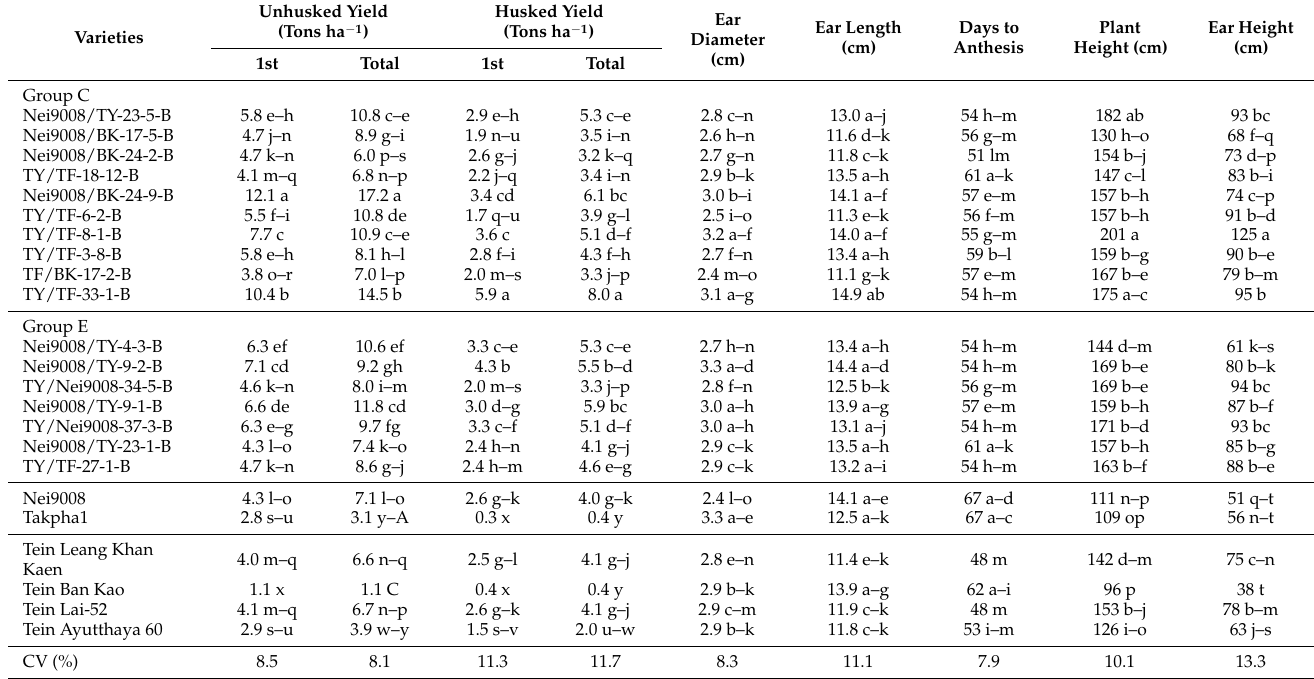
Table 3. Means for unhusked yield, husked yield, husked ear diameter, husked ear length days to anthesis, plant height and ear height of 17 orange small-ear waxy corn varieties and 6 check varieties in the rainy season 2020.